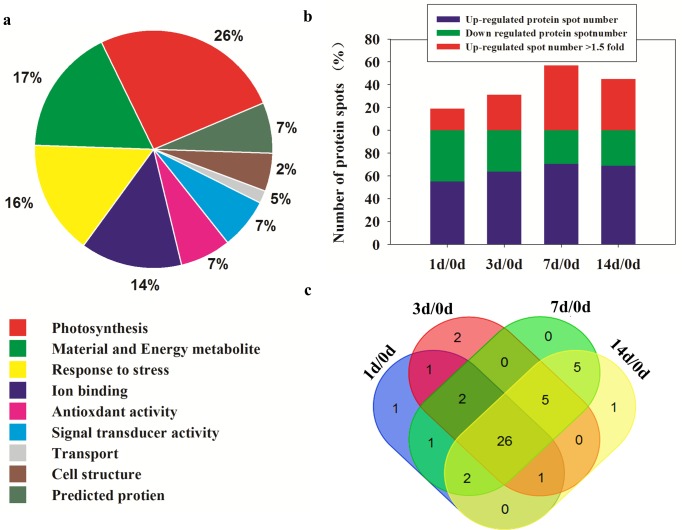
Differentially expressed proteins in S. purpurea seedlings under drought.(A). Functional classification of differentially expressed proteins in S. purpurea seedlings under drought. (B) Number of identified proteins showing changes in expression in each treatment (C). Venn-diagram showing overlap of upregulated proteins among 1d/0d, 3d/0d, 7d/0d, and 14d/0d.